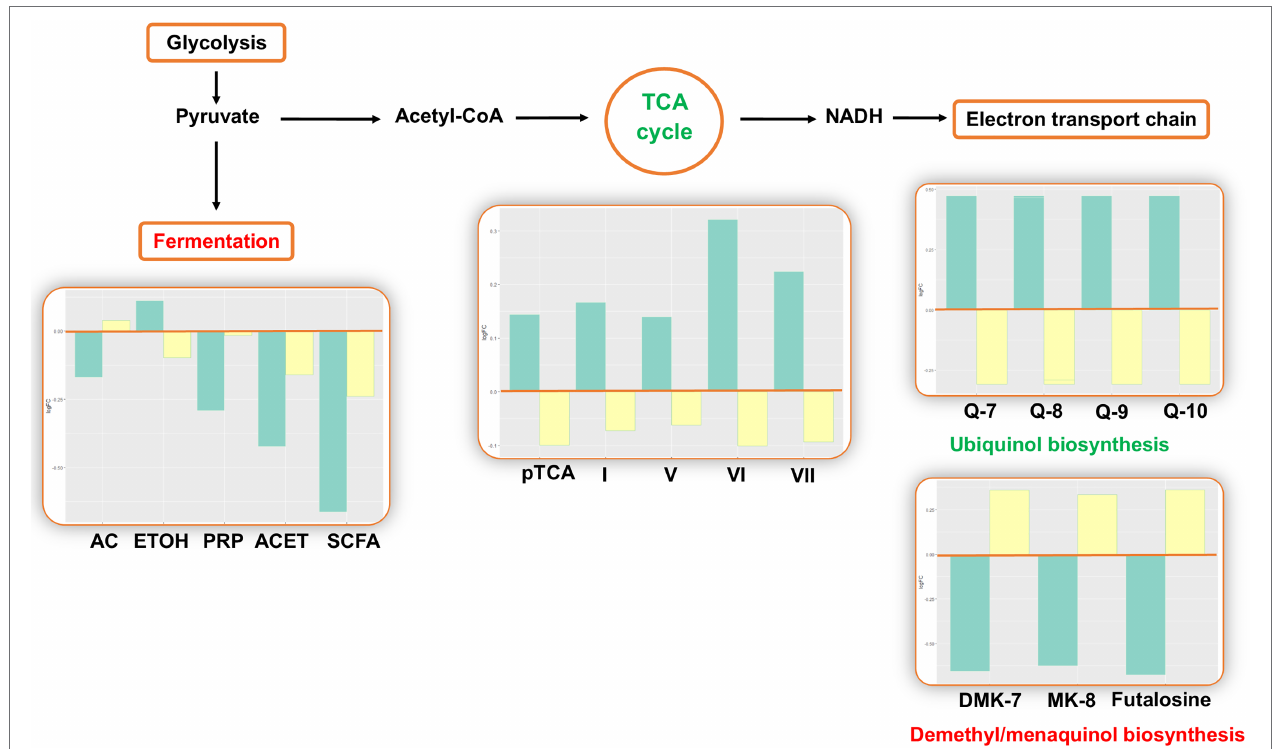
FIGURE 3 | Inferred changes in bacterial energy metabolism. The bar plots show log2 fold change from paired t tests (means relative to baseline, n = 23): green = after 2 days of heliox saturation; yellow = after decompression. AC, acetate ( p = 0.0354); ETOH, ethanol ( p = 0.0155); PRP, propanoate ( p = 0.0234); ACET, acetone ( p = 0.0047); SCFA, short-chain fatty acids ( p = 0.0014); pTCA, partial tricarboxylic acid (TCA) cycle (obligate autotrophs, p = 0.0240); I, TCA cycle I (prokaryotic, p = 0.0234); V, TCA cycle V (2-oxoglutarate synthase, p = 0.0360); VI, TCA cycle VI (Helicobacter, p = 0.0213); VII, TCA cycle VII (acetate-producers, p = 0.0368); Q-7, Ubiquinol-7 ( p = 0.0368); Q-8, Ubiquinol-8 ( p = 0.0368); Q-9, Ubiquinol-9 ( p = 0.0368); Q-10, Ubiquinol-10 ( p = 0.0368); DMK-7, demethylmenaquinol-7 ( p = 0.0266); and MK-8, menaquinol-8 ( p =